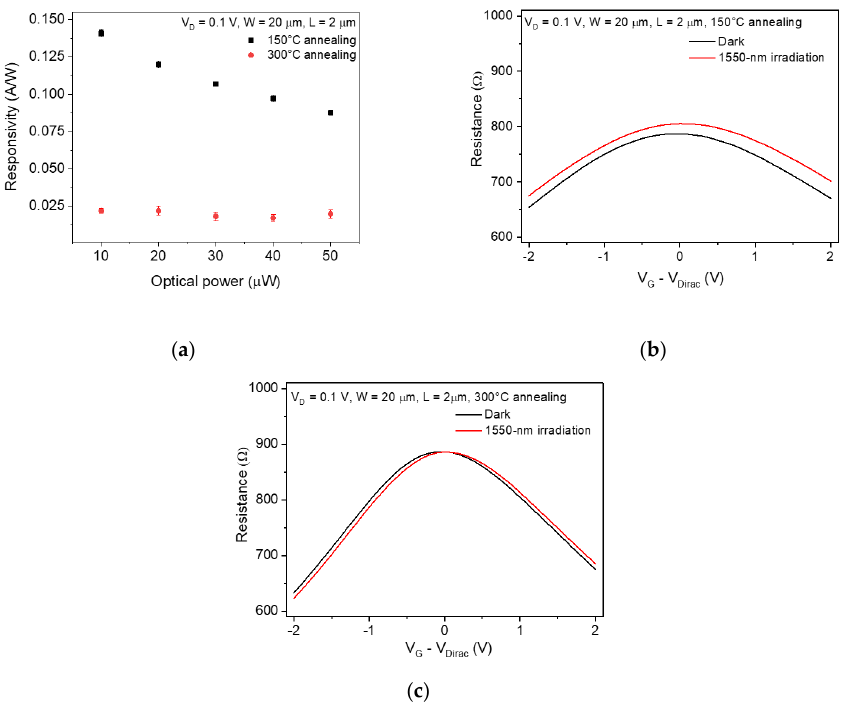
Figure 2. ( a ) Responsivity of the graphene photodetectors with the channel length of 2 µ m as a function of optical power after annealing at 150 ◦ C and 300 ◦ C. The error bar indicates a standard deviation. Total device resistance of the graphene photodetector as a function of gate bias measured after ( b ) 150 ◦ C and ( c ) 300 ◦ C annealing under dark and illuminated